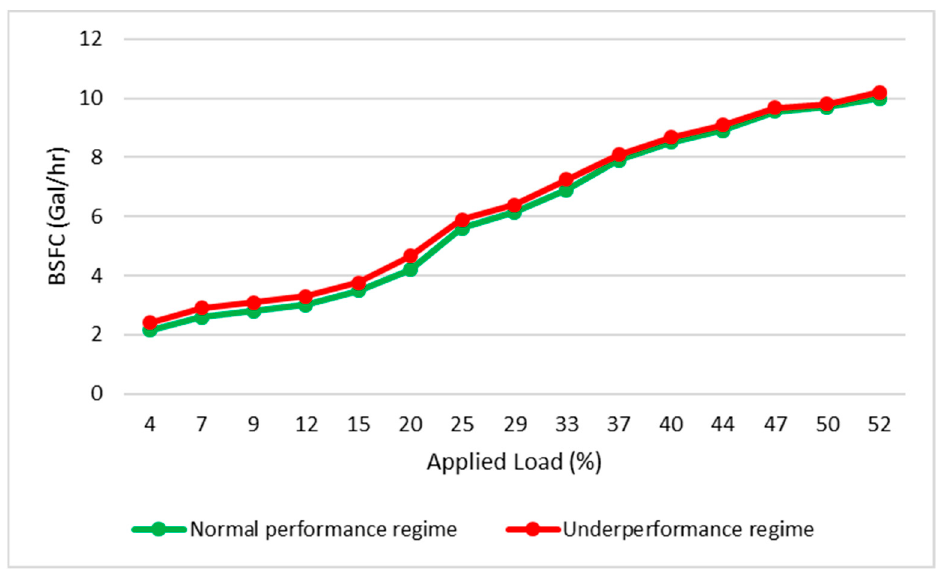
Figure 5. Break specific fuel consumption of the C9 fixed-speed diesel generator according to the applied loads under two scenarios.